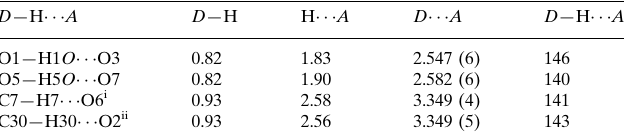
Hydrogen-bond geometry (A˚ , (cid:3)